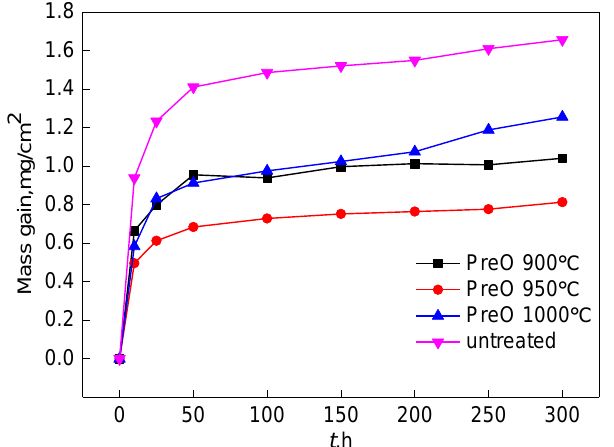
Figure 21. Oxidation kinetics curves of Al-Si coatings at different pre-oxidation temperatures at 1000 °C.